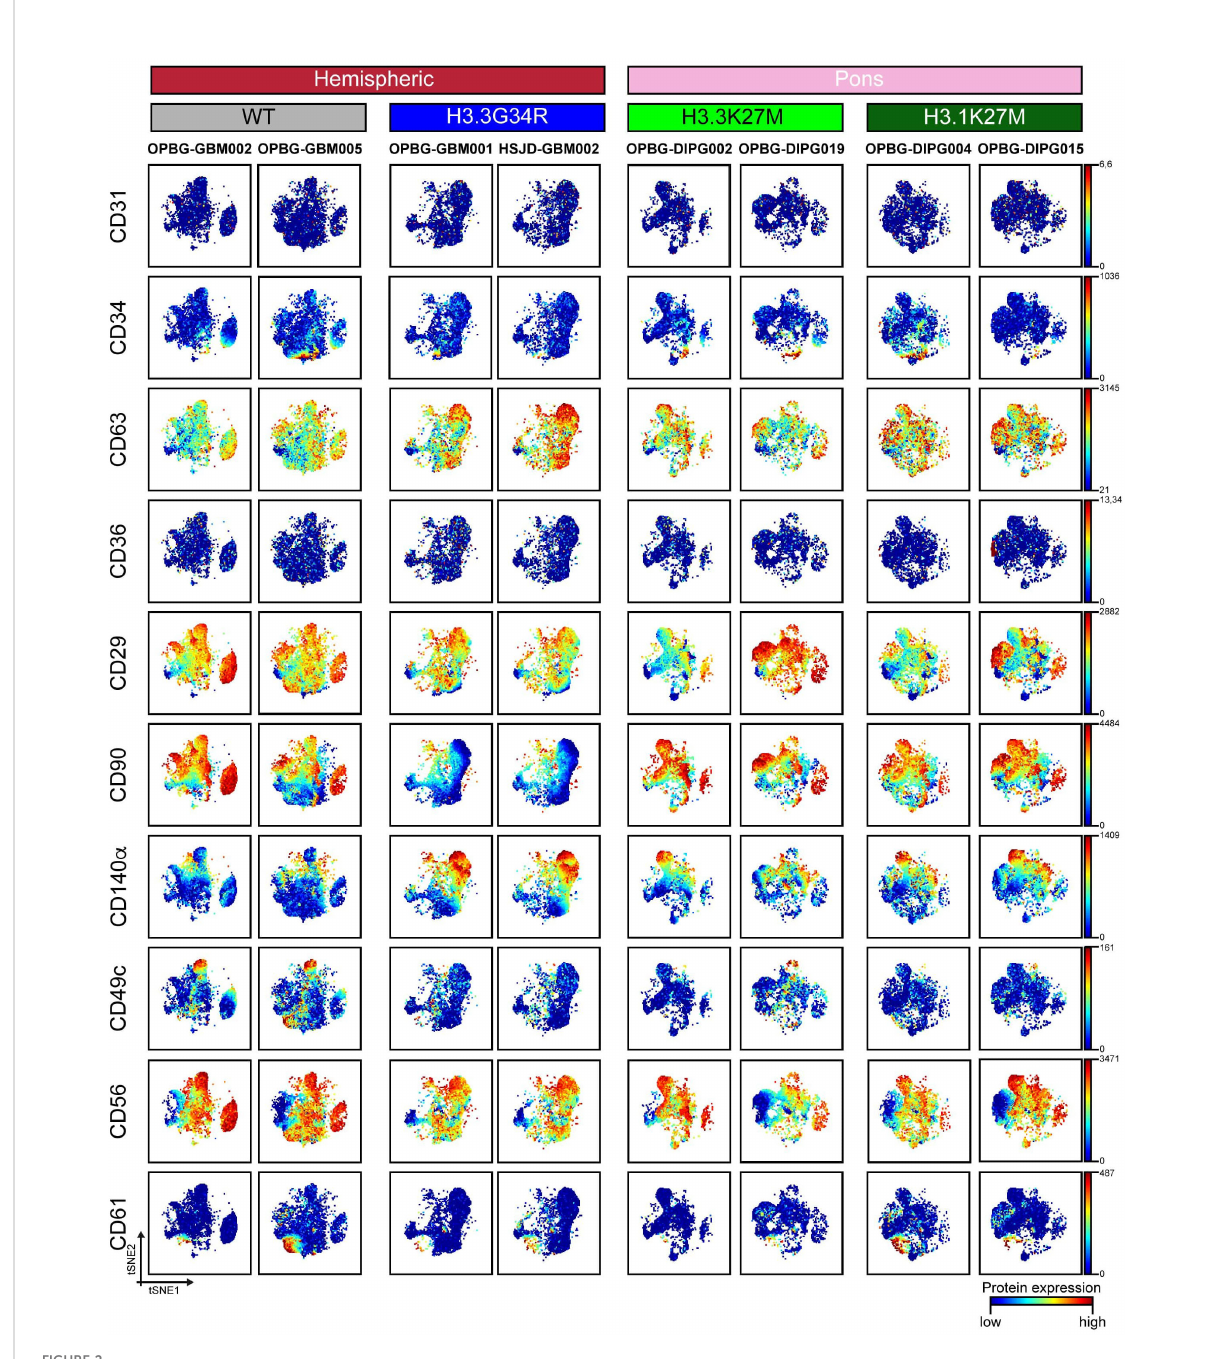
FIGURE 2 CyTOF single-cell analysis of surface antigens in PDHGG patient-derived cell lines. t-SNE maps showing the expression of 10 surface markers (CD31, CD34, CD63, CD36, CD29, CD90, CD140a, CD49c, CD56 and CD61) in each of the eight different PDHGG patient-derived cell lines analyzed through mass cytometry technique. The color gradient refers to the intensity of the expression of the considered marker, in a blue to red scale indicating low and high intensity